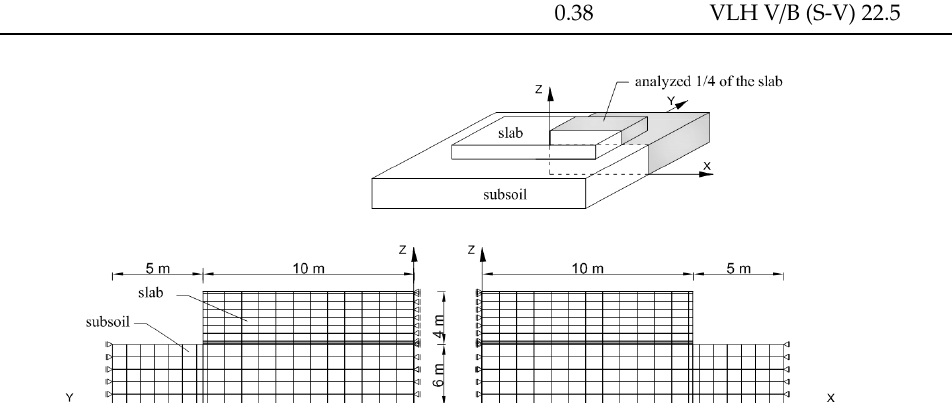
Figure 5. Finite element mesh for the exemplary slab.